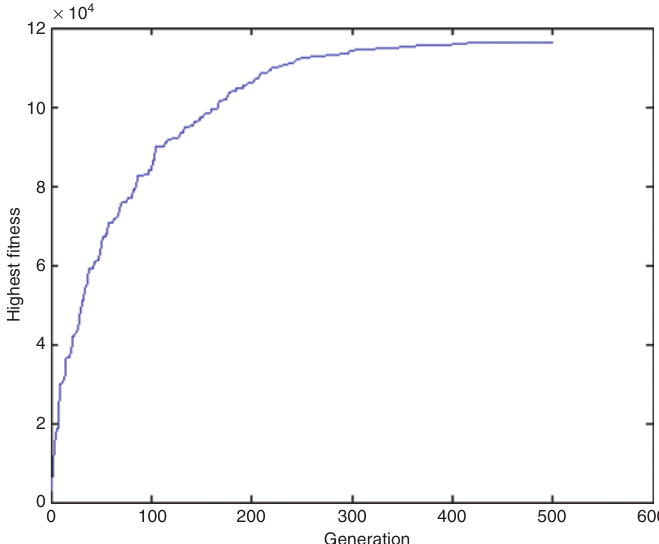
Figure 3. Fitness of the Historically Best